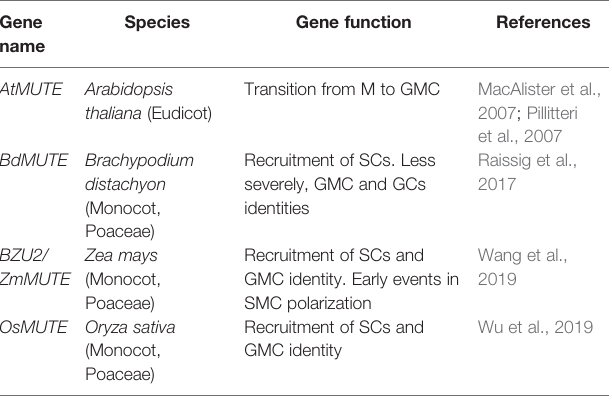
TABLE 1 | Functions of AtMUTE and MUTE orthologues of